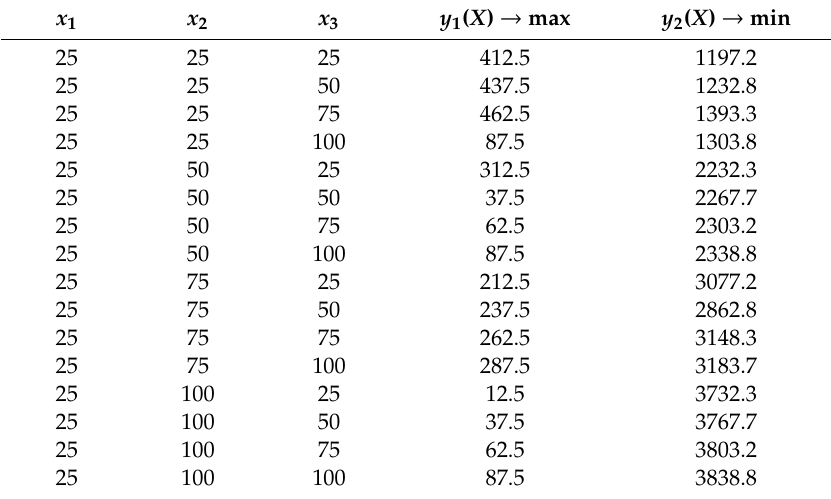
Table 6. Numerical values of parameters and characteristics of the